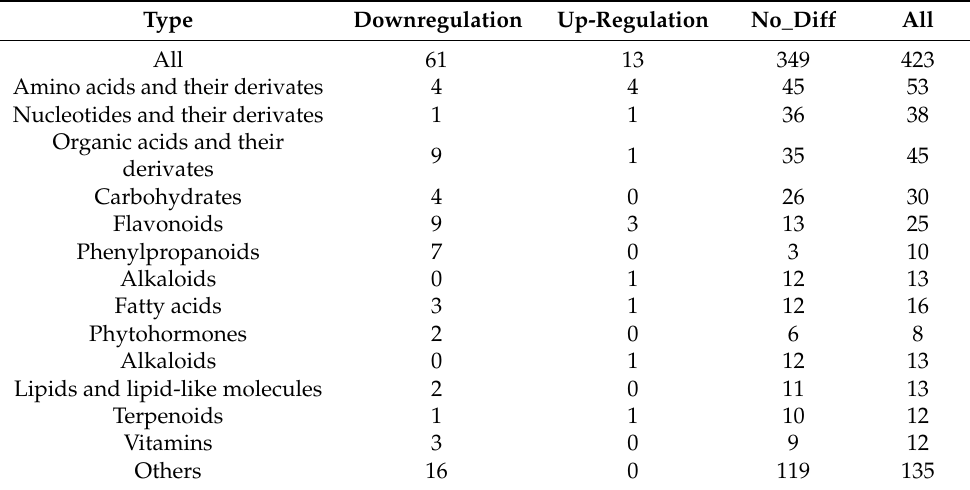
Table 1. Significantly altered metabolites in M. micrantha leaves under